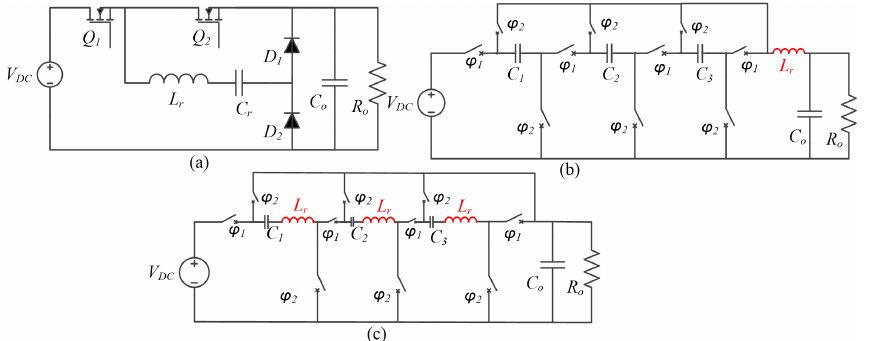
Figure 5. Resonant switched-capacitor converters; ( a ) basic form, ( b ) with a single inductor at output and ( c ) with distributed inductors.